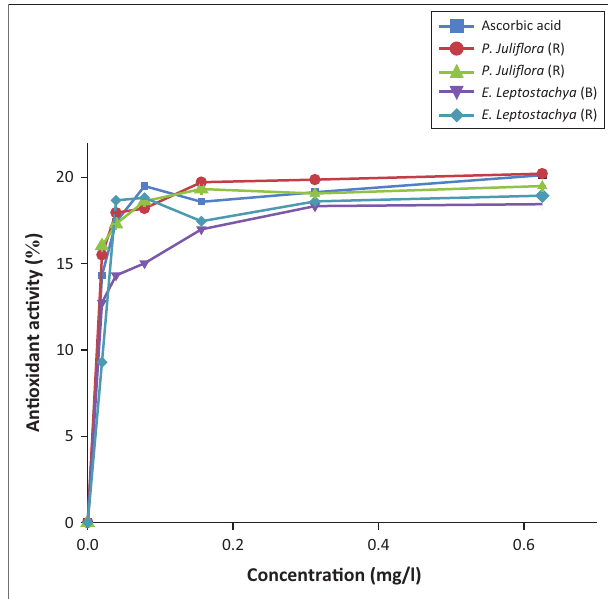
FIGURE 6: β-carotene bleaching assay of P. juliflora (roots and leaves) and E. leptostachya (barks and roots). TABLE 4: Zone of inhibition of P. juliflora (leaves and roots). Plant